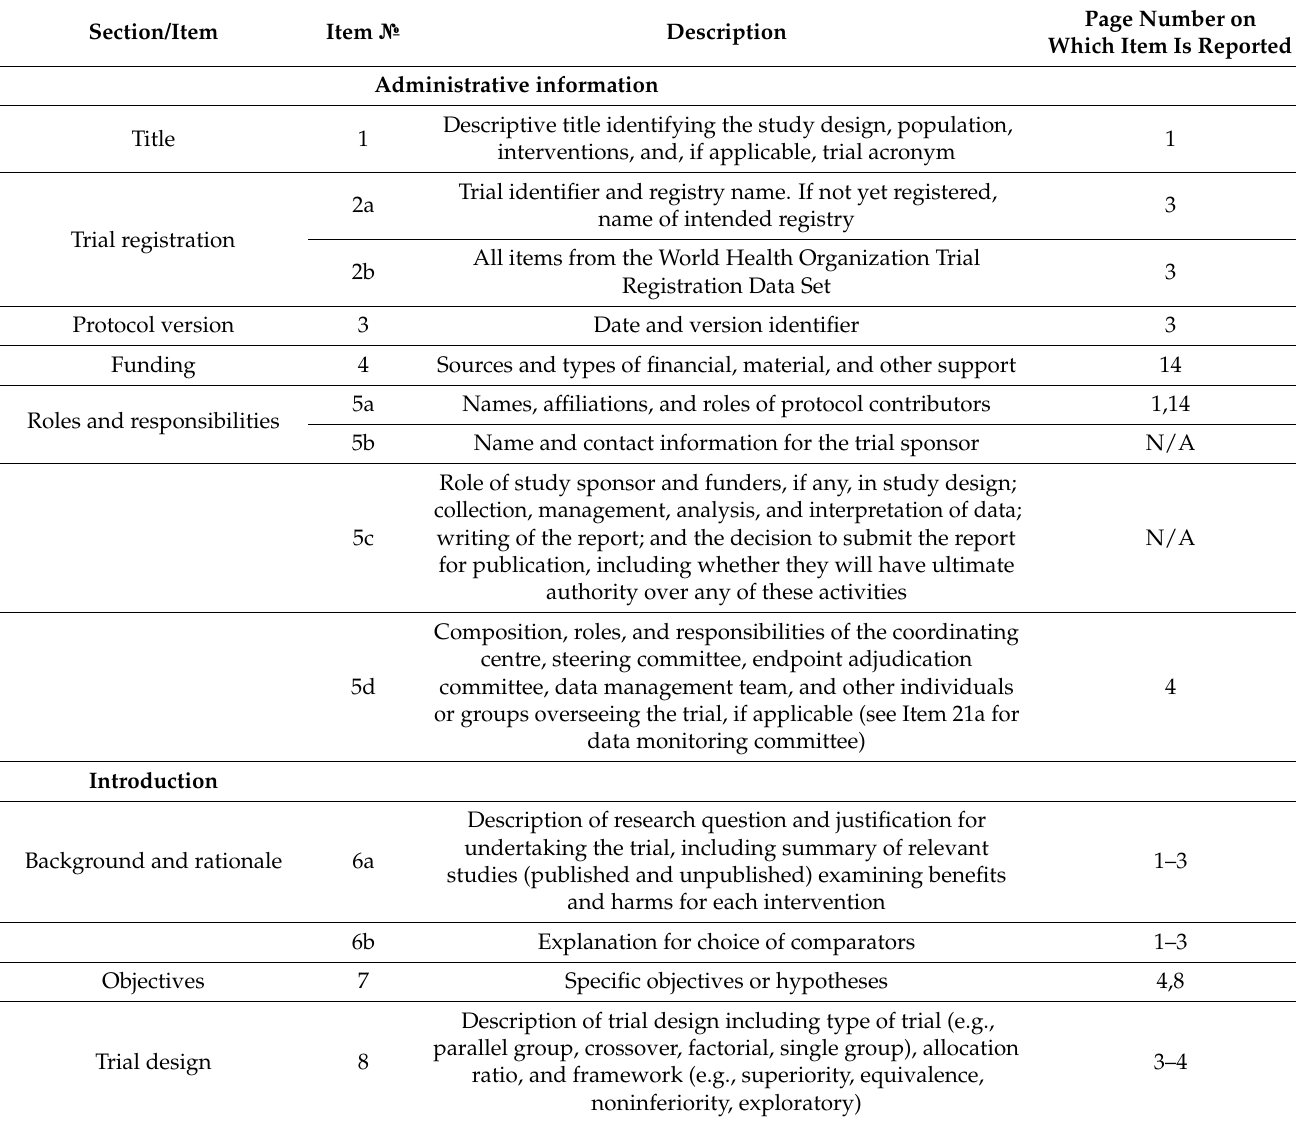
Table A1. SPIRIT 2013 Checklist: Recommended items to address in a clinical trial protocol and related documents *.